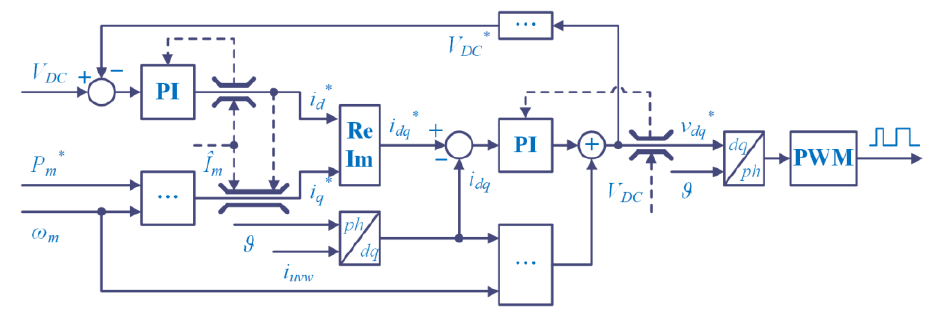
Figure 6. M/G-side converter control system overview.